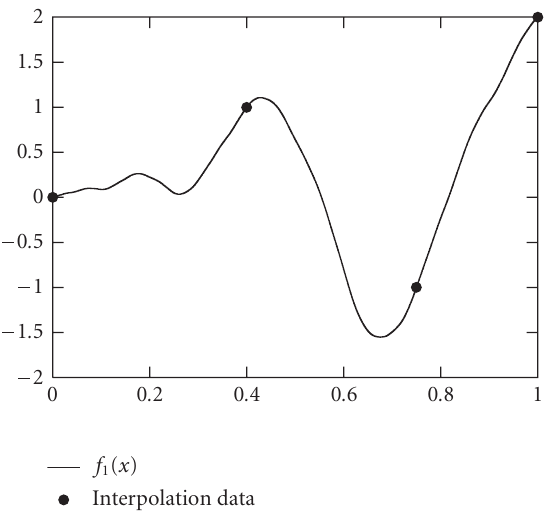
Figure 5.8. Self-a ffi ne spline